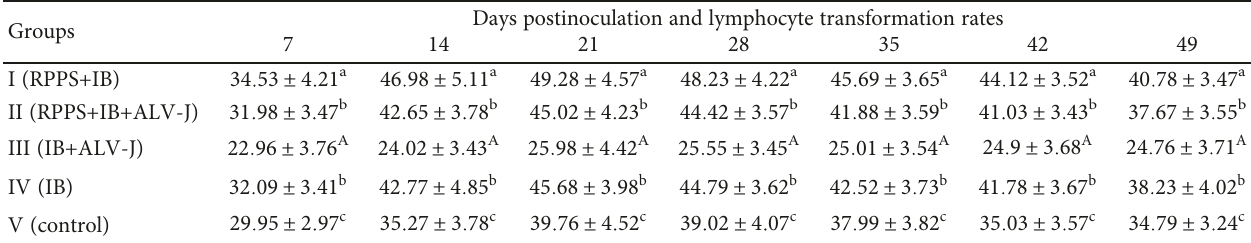
Table 1: E ff ects of RPPS on CD4 + T lymphocyte in the peripheral blood. Groups